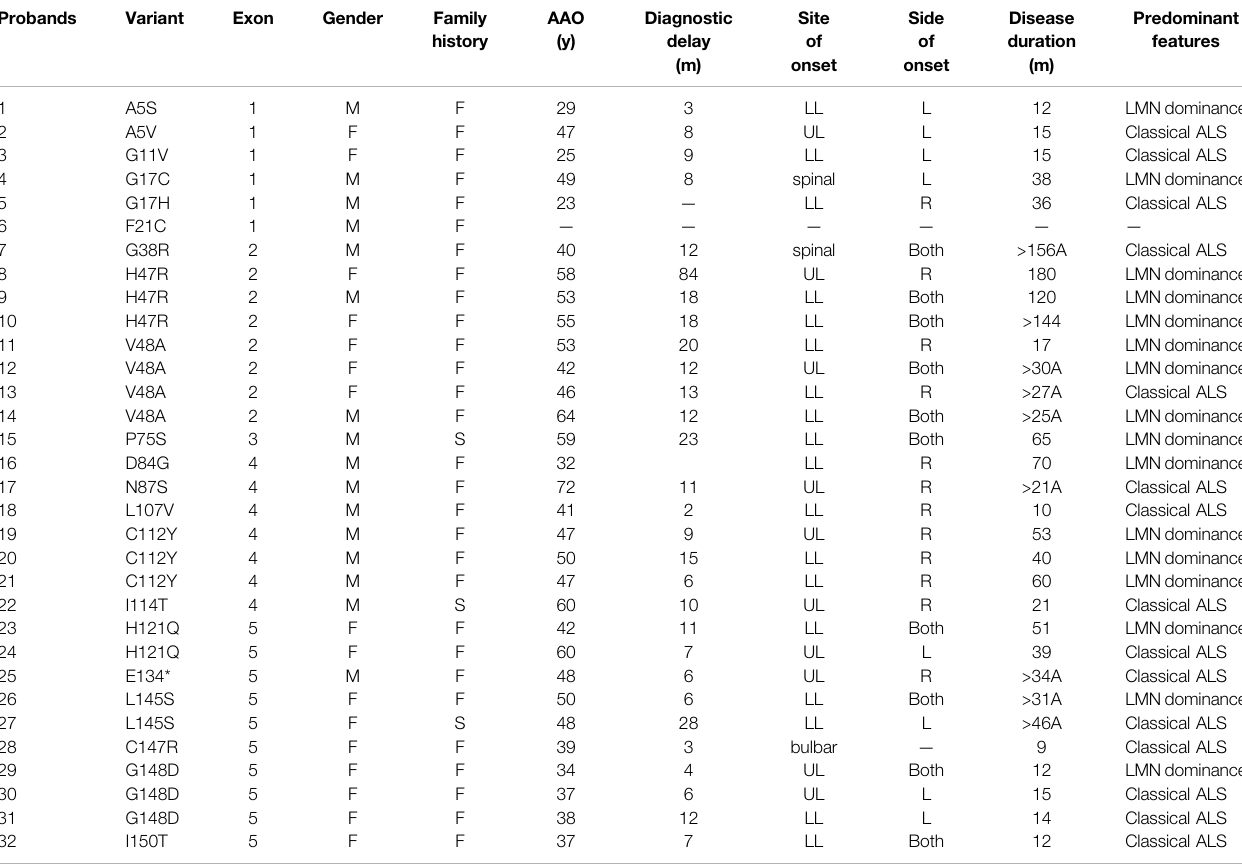
TABLE 1 | The clinical features of the probands carrying mutations in SOD1 . Probands